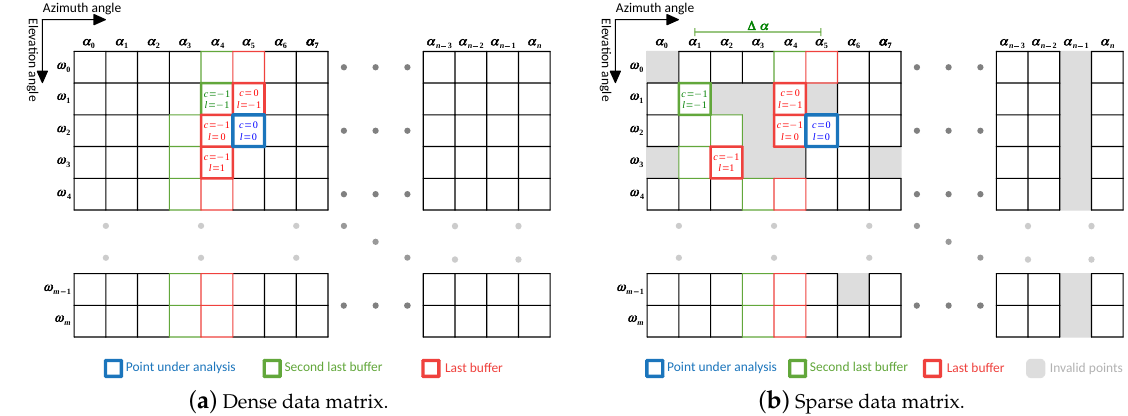
Figure 5. Point analysis